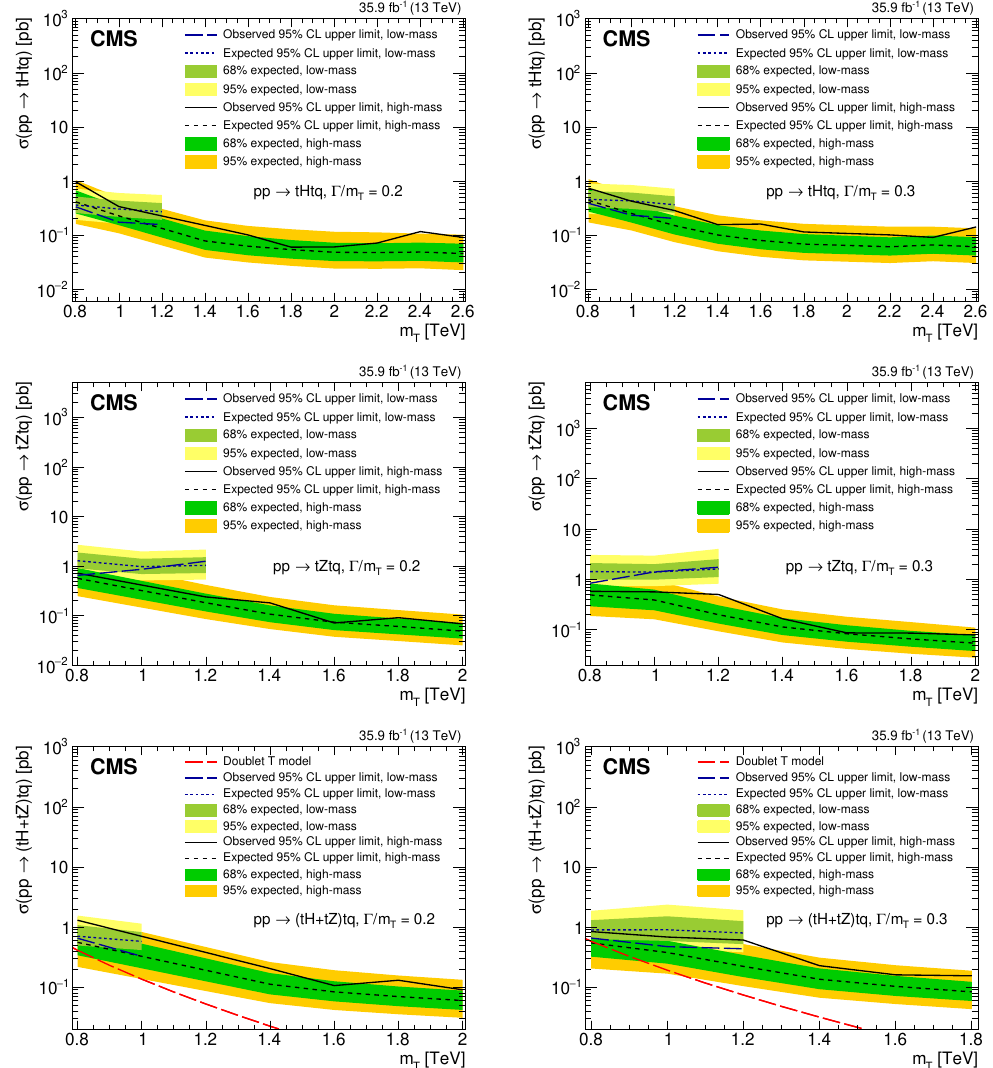
Figure 15 . The observed and median expected upper limits at 95% CL on the cross sections for production associated with a top quark for the tHtq (upper row) and tZtq (middle row) channels, and their sum, tHtq+tZtq (lower row), for di(cid:11)erent assumed values of the T quark mass. The inner (green) bands and the outer (yellow) bands indicate the regions containing 68 and 95%, respectively, of the distribution of limits expected under the background-only hypothesis. The left column is for a fractional width of 20% and the right column is for a fractional width of 30%. The dashed red curves are for the (TB) doublet model. Given the speci(cid:12)ed width, the couplings are implicit in the